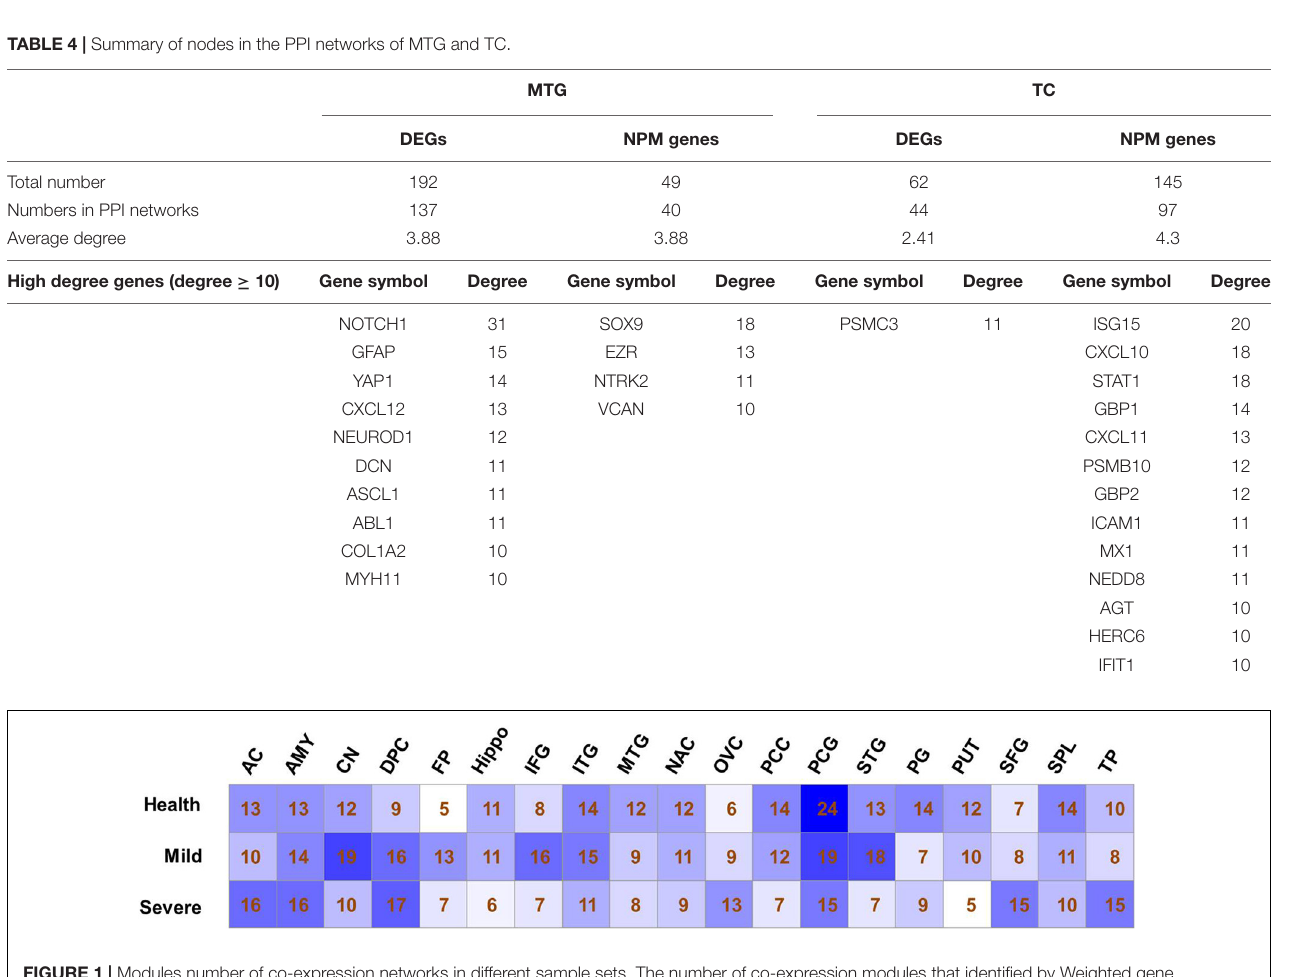
TABLE 4 | Summary of nodes in the PPI networks of MTG and TC.